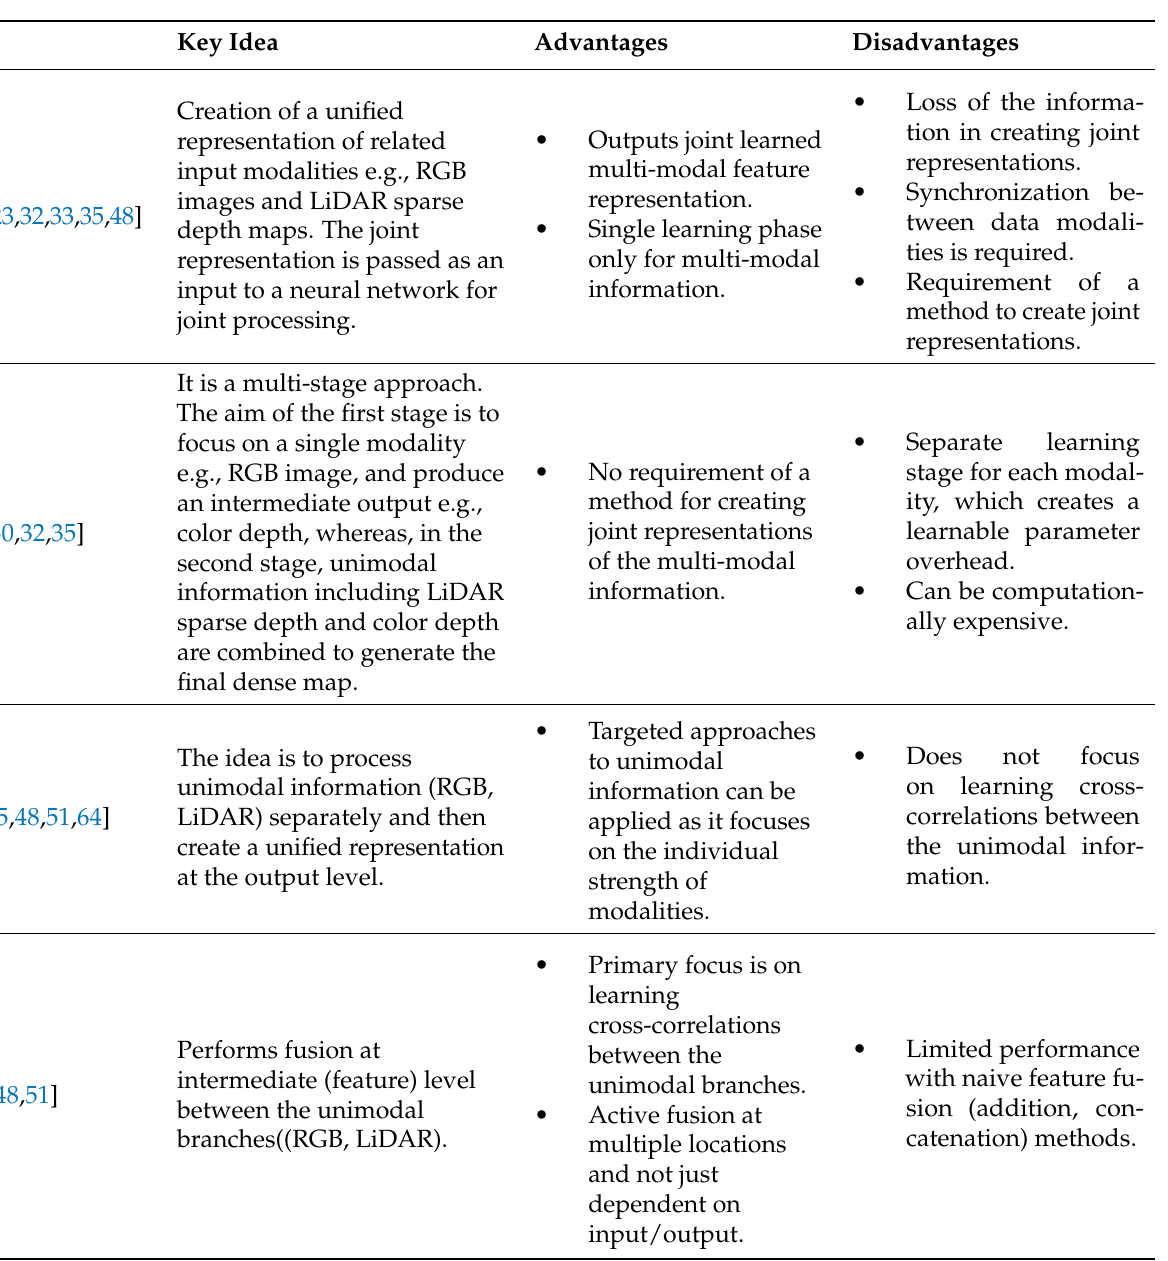
Table 1. Comparison of fusion